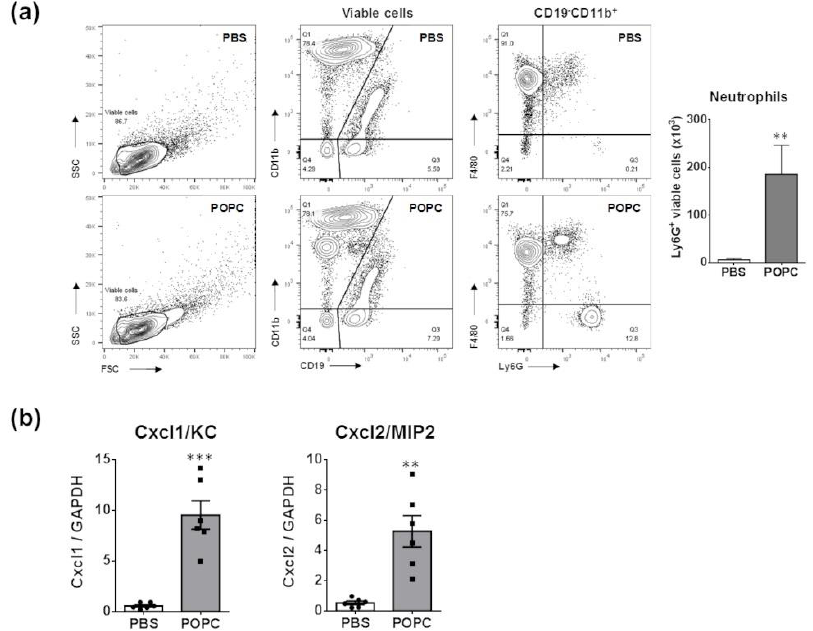
Figure 10. POPC liposomes elicit the rapid recruitment of neutrophils into the peritoneal cavity. ( a ) POPC liposomes (400 µ g) or an equal volume of PBS (carrier) were injected into the peritoneal cavity of male CD-1 mice, and peritoneal cells were collected by lavage after 1 h of liposome exposure. The phenotypic analysis of peritoneal cells was performed by flow cytometry using a FACSCanto II flow cytometer as described in the Section 2. The data were analyzed using FlowJo software, and the bar graph indicates the number of viable neutrophils defined as CD19 − CD11b + Ly6G + in POPC-treated vs. PBS-treated peritoneal cells. Data ( n = 6) are expressed as means±SEM, and statistical analysis for the comparison between groups was performed using un- paired Student’s t -test with ** indicating p < 0.01 vs. PBS controls. ( b ) CD-1 mice ( n = 6 per group) were injected with POPC liposomes or an equal volume of PBS (carrier). Peritoneal cells were har- vested 1h after the injection and processed for RNA isolation and qPCR analysis. Bar graphs show the mRNA levels for the neutrophil-recruiting chemokines Cxcl1 and Cxcl2. The housekeeping gene GAPDH was used to normalize data to cDNA inputs. Results are expressed as means ± SEM, and statistical analysis for the comparison between groups was performed using unpaired Student’s t - test with ** indicating p < 0.01 and *** indicating p < 0.001. Altogether, these results indicate that PC is capable of initiating an inflammatory re- sponse in macrophages by triggering the activation of the NF- κB pathway, which results in the expression of numerous inflammatory mediators, including some involved in the recruitment of neutrophils, such as Cxcl1 and Cxcl2. 4. Discussion The lipid composition of eukaryote cellular membranes is complex, in which glycer- ophospholipids are the major component, with the additional presence of sphingolipids and sterols [13]. Indeed, the lipid organization of all subcellular membranes, including the plas- malemma, is different and specific for each subcellular compartment [14]. Moreover, phos- pholipid membranes are key components of the export of vesicles into the extracellular en-